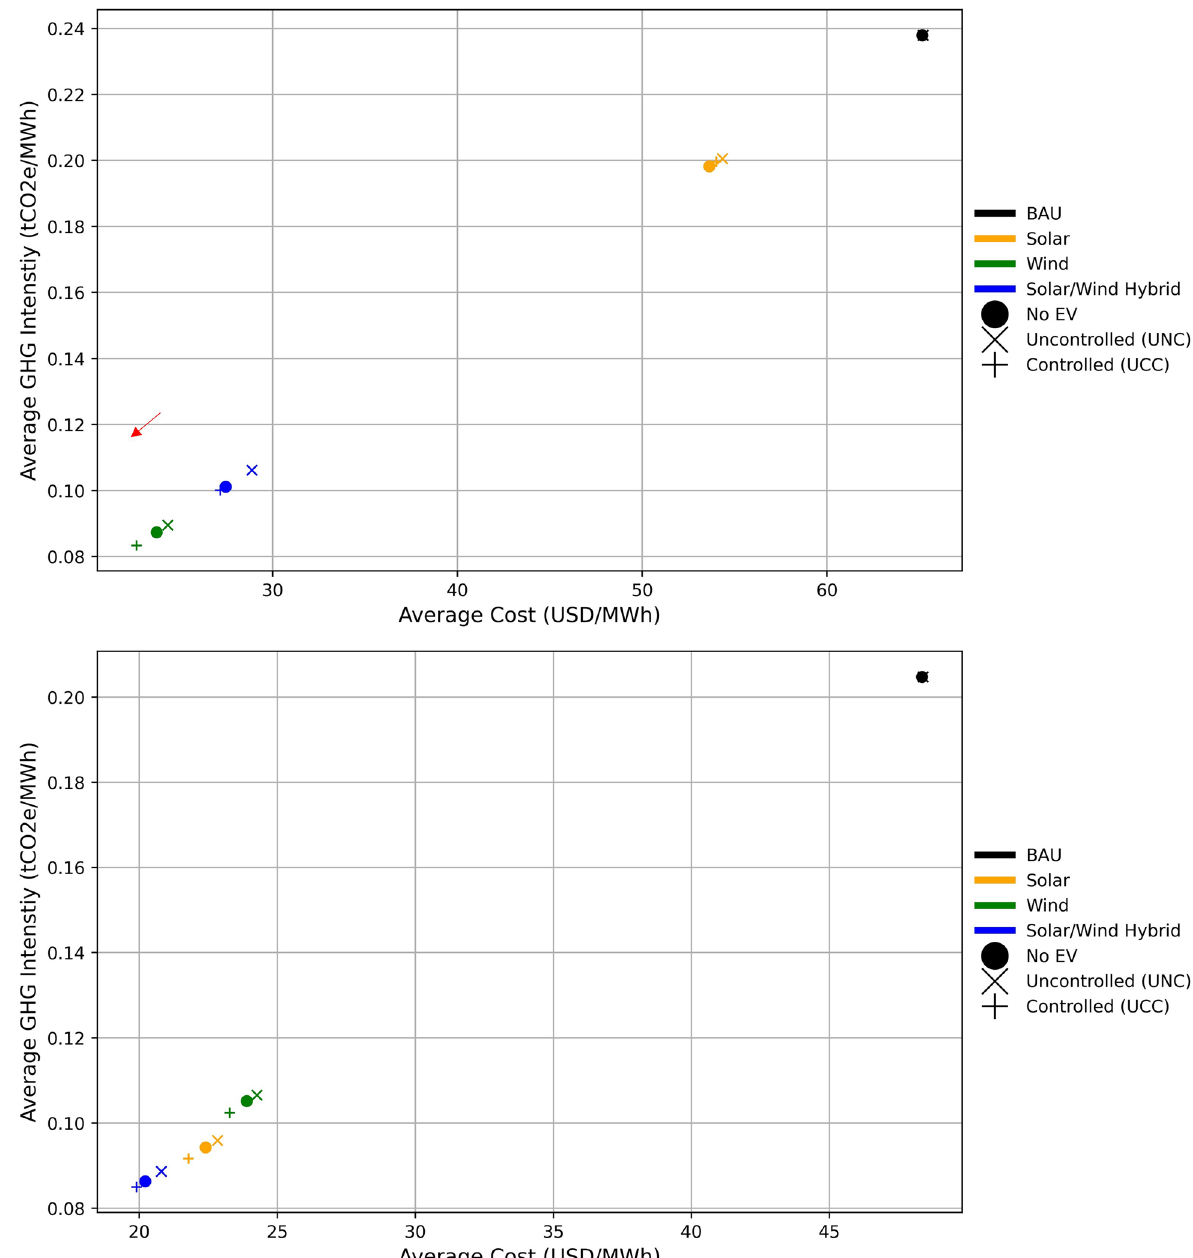
Fig. 10 Average operational cost vs. average operational GHG emissions intensity from electricity generation for a January week (top) and b